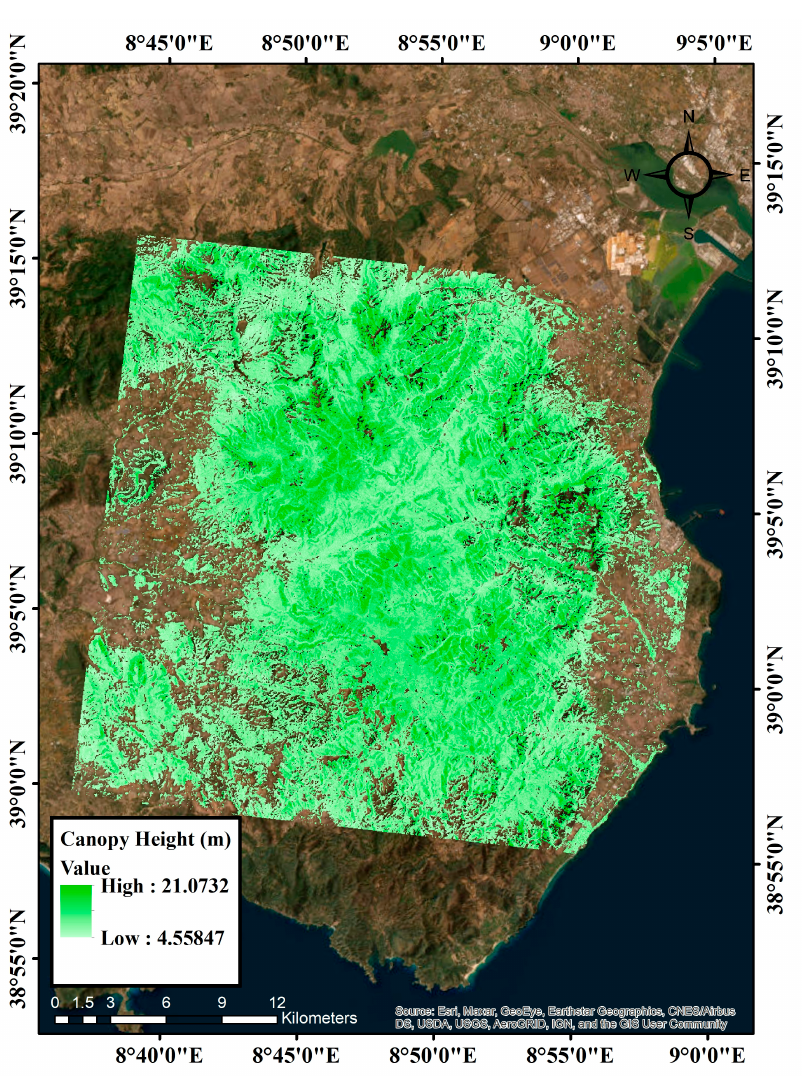
Figure 6. Canopy height map for canopy higher than 4.5 m. Darker green means higher canopy height.